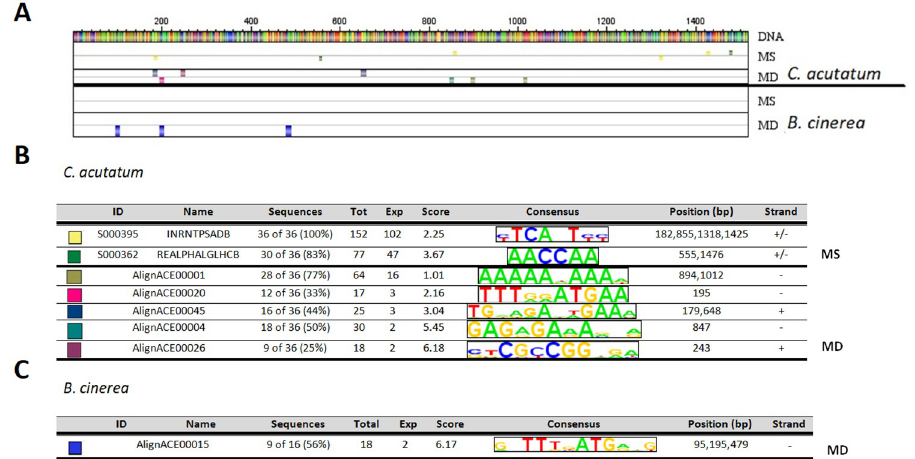
Fig 6. FanRALF6 In silico analysis of predicted regulatory elements in pathogen-induced fragaria genes. (A) From the top: the FanRALF6 gene putative promoter, Motif Scanning (MS) and Motif Discovery (MD) outputs resulting from the analyses of C . acutatum- induced genes, and MS and MD outputs from the analysis of B . cinerea- induced genes 24 h post-infection. Small colored boxes in MS indicate known regulatory elements from PLACE database found to be significantly abundant in the group of sequences analyzed and in FanRALF6 putative promoter, while large coloured boxes in MD represent sequences found significantly enriched in the upstream sequences of genes analyzed. (B) and (C) are the color key respectively for C . acutatum and B . cinerea reported in (A). Codes and names of regulatory elements are reported, together with elements percentage abundance among sequences analyzed (Sequences), total count of elements found (total), element background frequency calculated as number of elements found in a third order random generated sequences (Exp), ranking score values calculated by MotifLab software using a binomial test with p-value threshold of 0.05 (Score). Consensus sequence of each element is shown along the position of the element in the putative FanRALF6 promoter (Position bp) and the strand in which it is found.